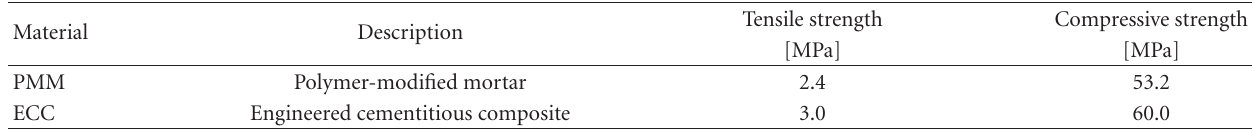
Table 2: Material properties for binders used in experimental